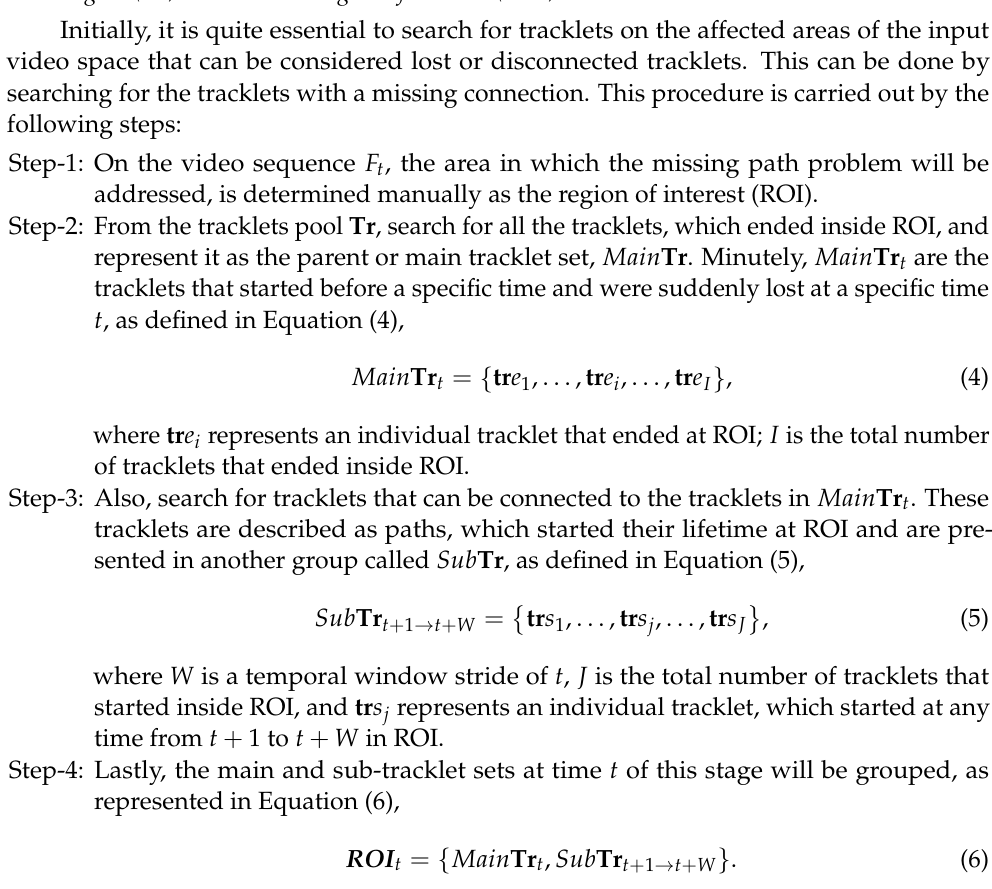
Figure 3. Steps of the process of the HTA algorithm. ( a ) Methodology flowchart. ( b ) An illustrative example of the HTA process. The tracklets that are illustrated by yellow color, tr e l and tr s r , are associated as one path at a final stage.